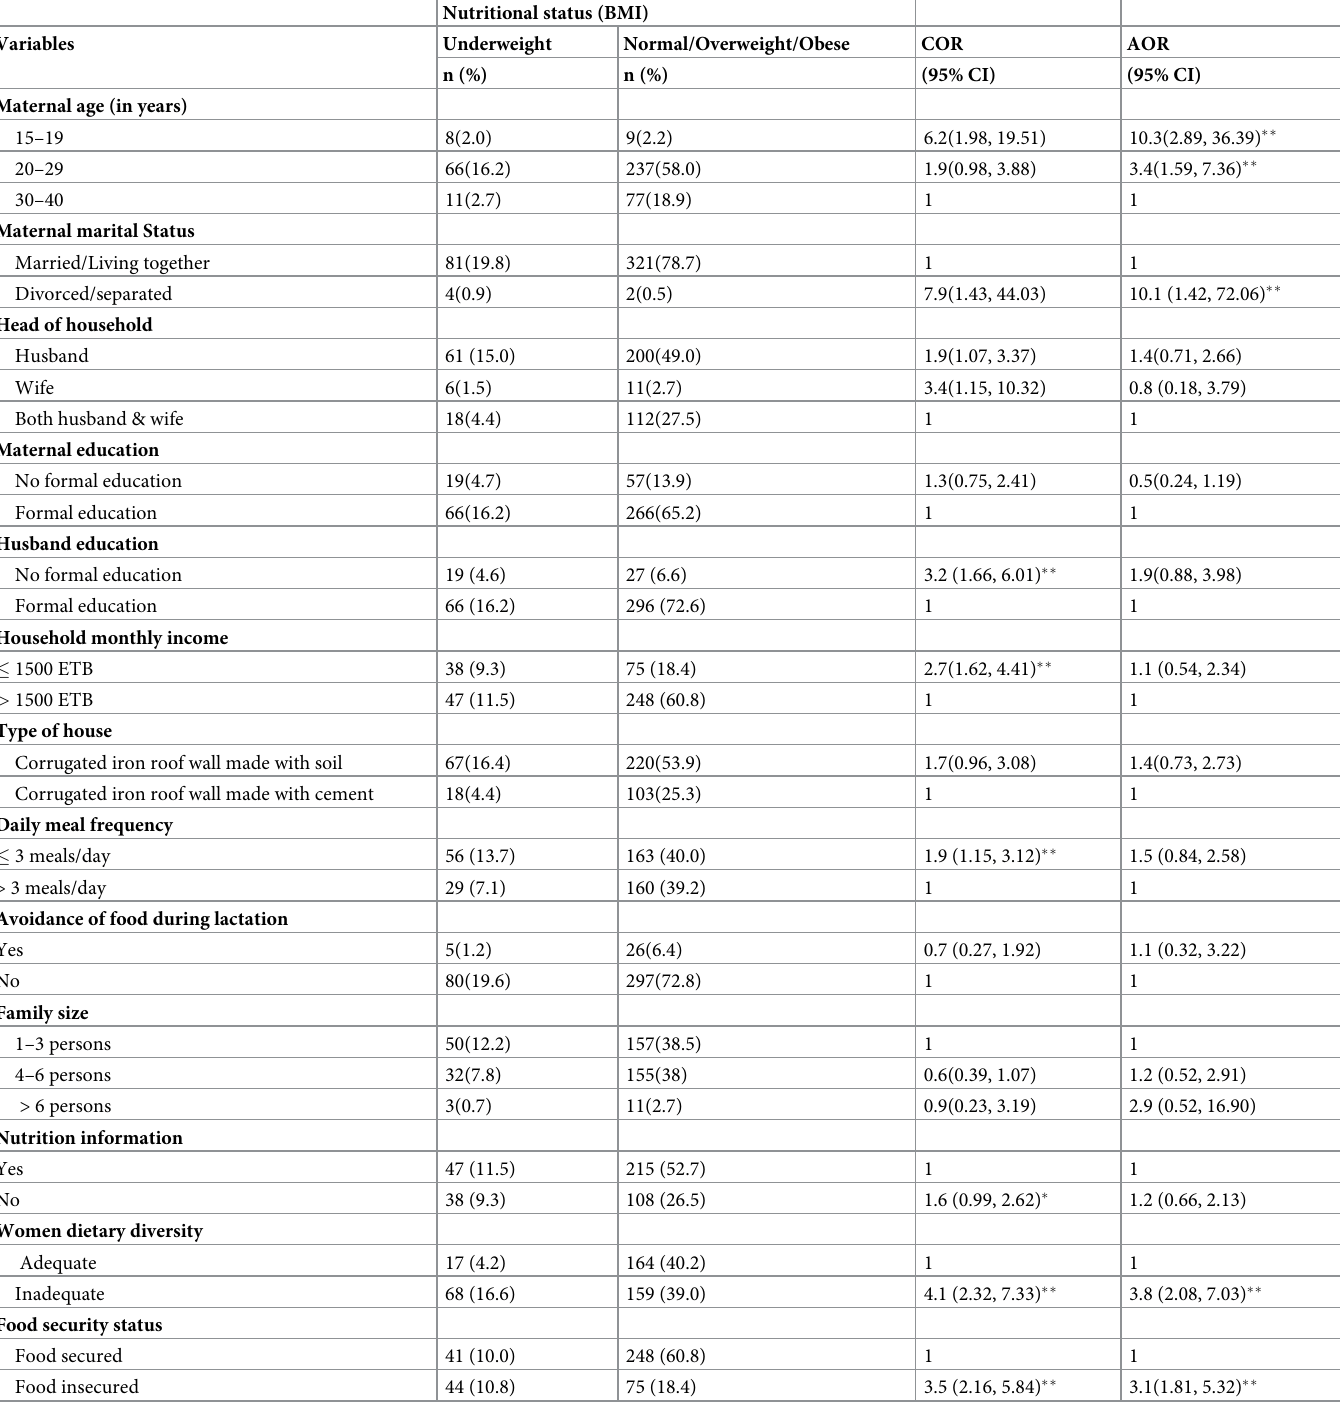
Table 4. Association of variables with nutritional status of lactating mothers (n = 408) visiting governmental health facilities of Dessie town, Ethiopia, March- April,